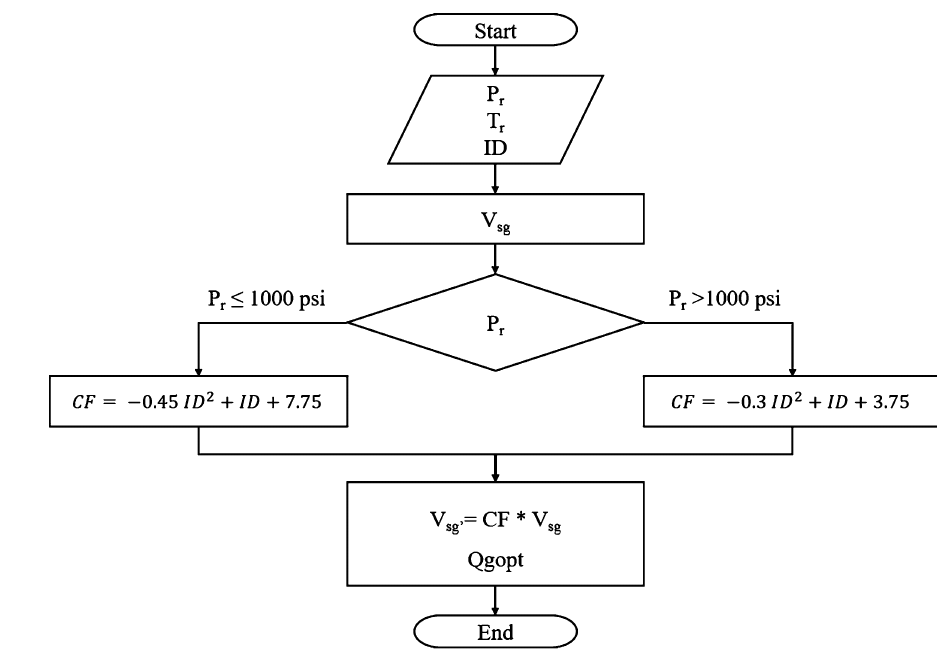
Fig. 9 Flowchart for FPM and correction factor